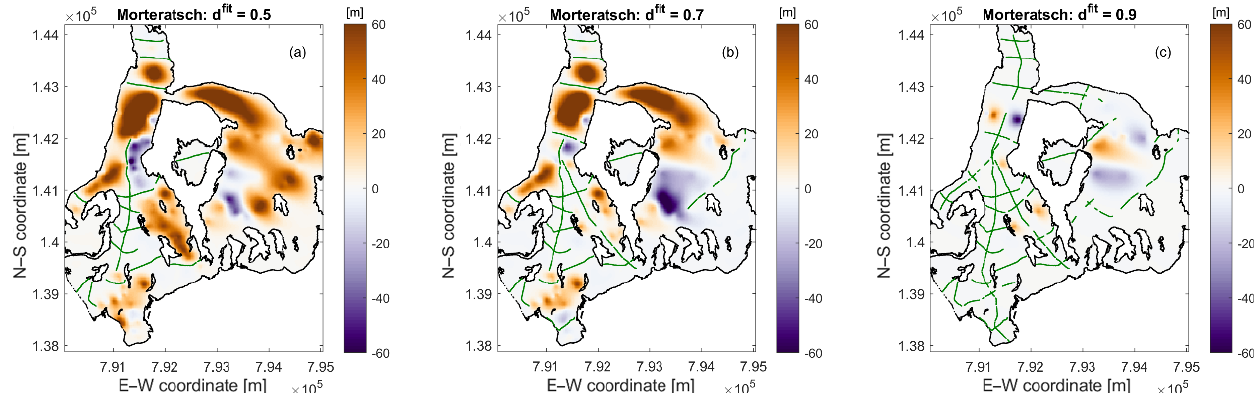
Figure 6. Vadret da Morteratsch model misfit h true − h est k after selected stages of the experimental design procedure using observed data (see also vertical dashed lines in Fig. 5). The selected GPR profiles are superimposed with green lines.